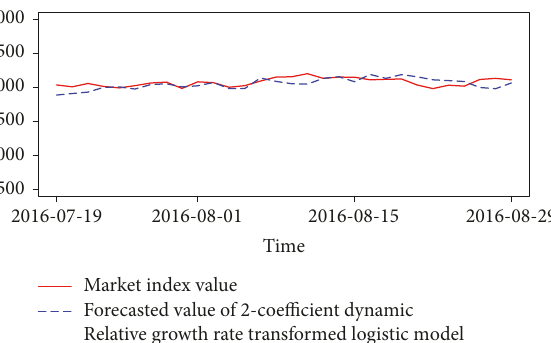
Figure 18: Time plots of raw data and the forecasts of model B, C and the martingale.